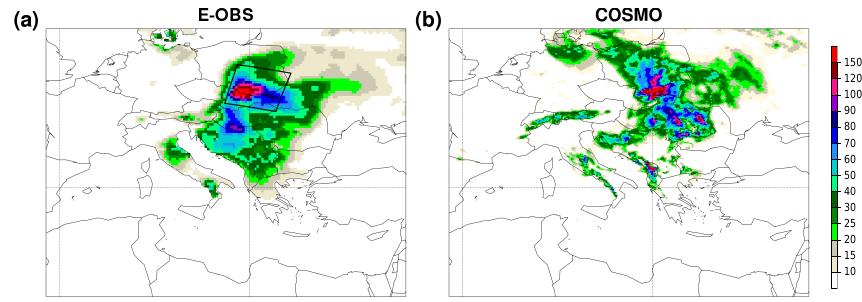
Figure 3. (a) Observed (E-OBS data set; Haylock et al., 2008) and (b) simulated (COSMO) 72-hourly accumulated precipitation in mm between 00:00UTC on 15 May and 00:00UTC on 18 May 2010. The black frame in (a) shows the target region.